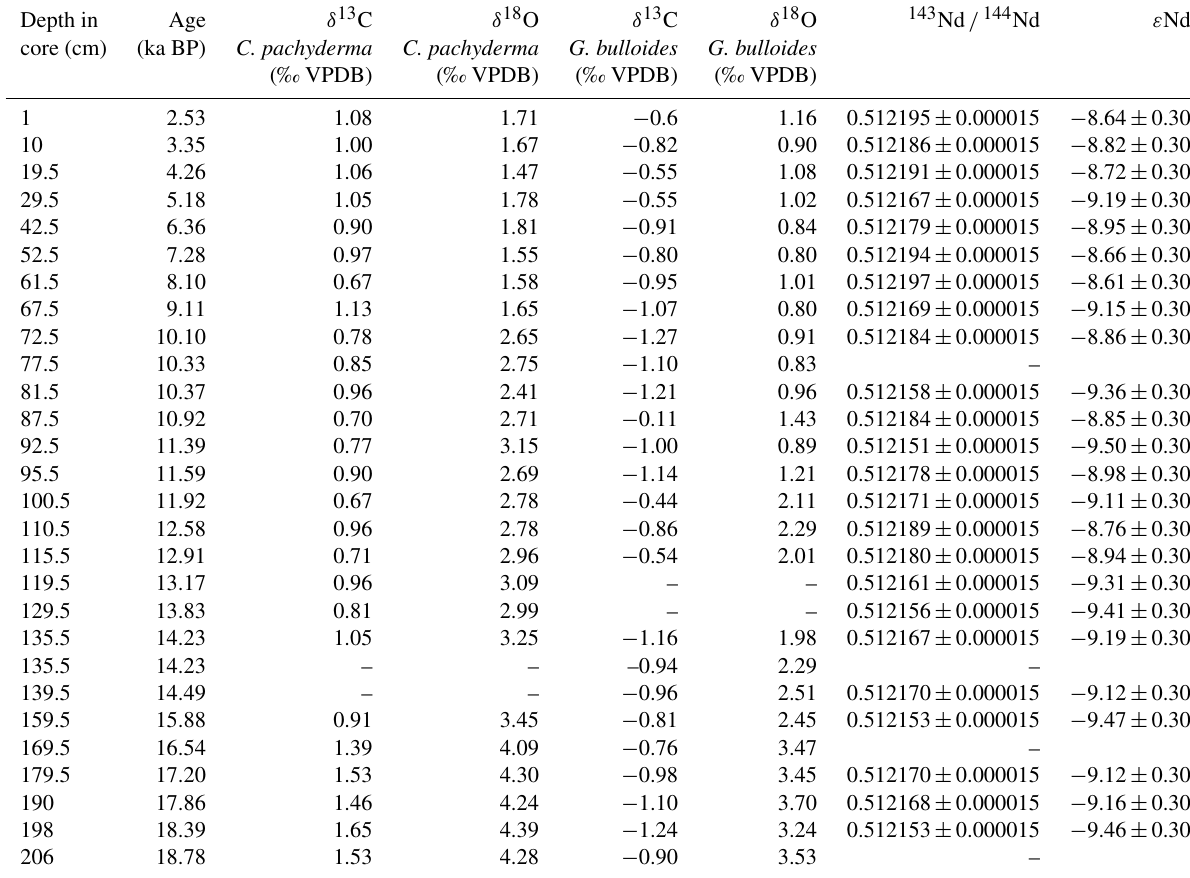
Table 4. Multiproxy data obtained for the upper 2.1m of sediment core SU92-33 (Balearic Sea). Stable oxygen and carbon isotopes were measured on benthic ( C. pachyderma ) and planktonic ( G. bulloides ) foraminifera; ε Nd values were obtained on mixed planktonic foraminifera samples. The age results from a combination of seven AMS 14 C age measurements for the upper 1.2m of the core and by a linear interpolation between these ages as well as the δ 18 O variations of the planktonic foraminifera G. bulloides